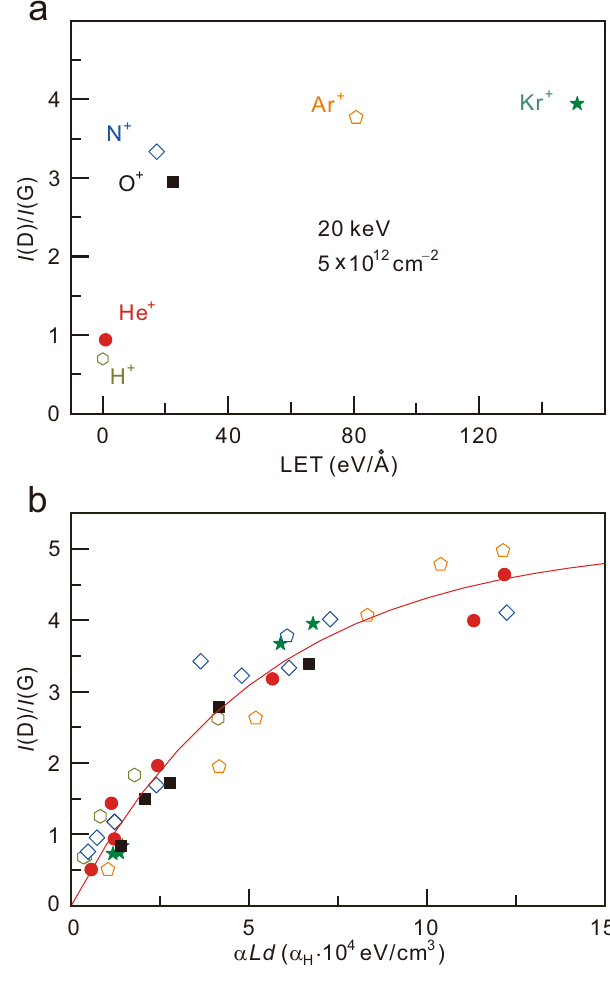
Figure 4. ( a ) I (D)/ I (G) as a function of the LET for different ion species and the same energy and dose. ( b ) All I (D)/ I (G) data points as a function of α ·L·d